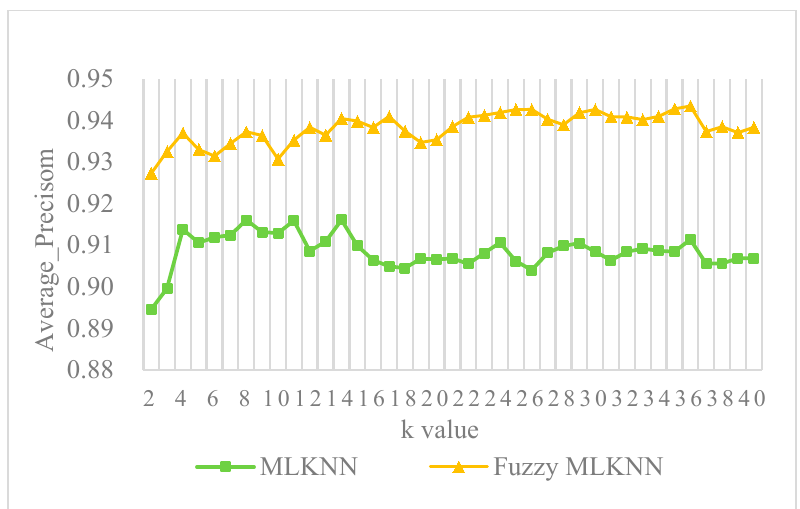
Figure 2. Average_Precision under different K values.